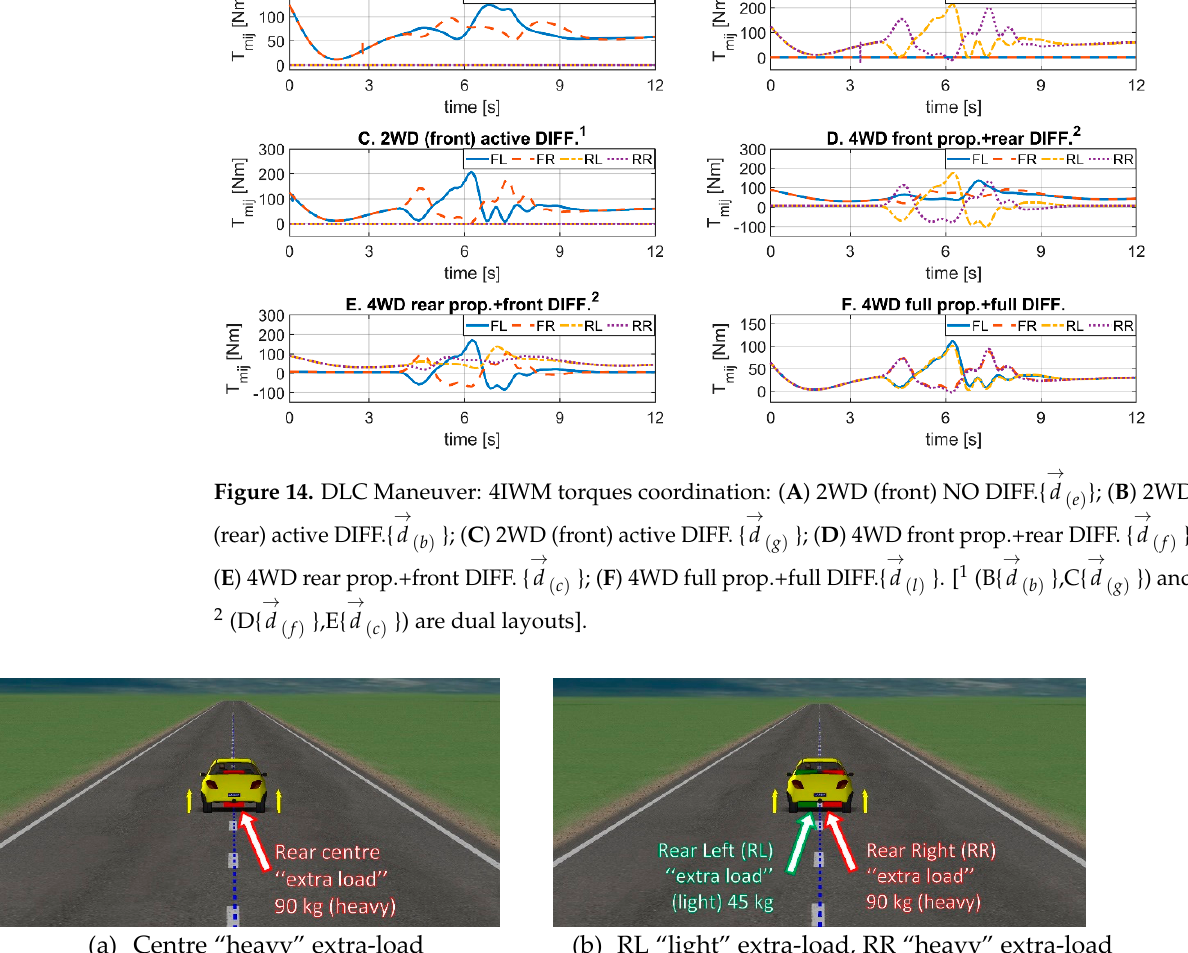
Figure 15. SV Equalization: Extra-load imbalance.